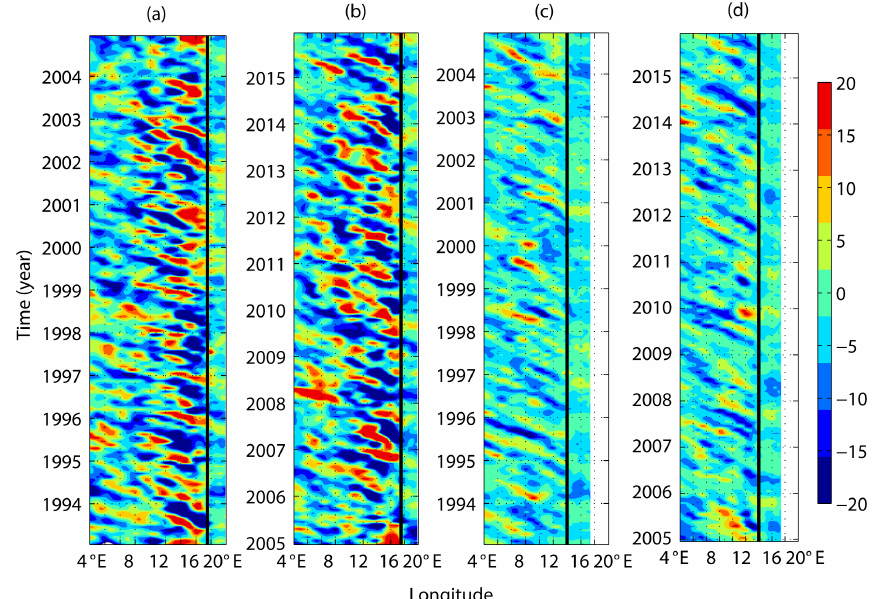
Figure 7. Hovmöller diagram of monthly sea surface height anomalies (in cm) across 35 ◦ S (a, b) and 30 ◦ S (c, d) . Anomalies are stronger west of the black line located at 17.5 ◦ E for 35 ◦ S and at 14 ◦ E for 30 ◦